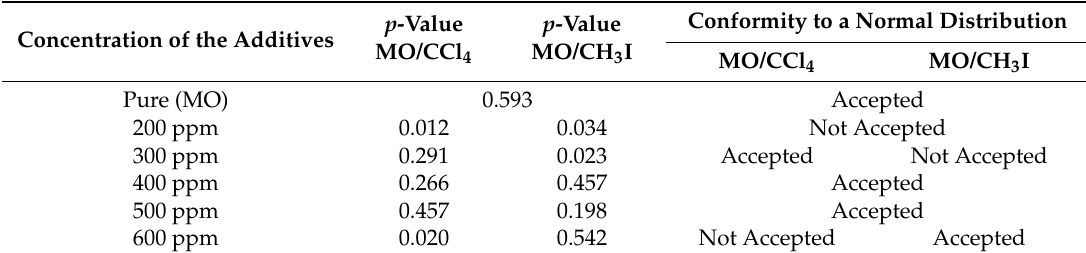
Table 3. The p -value of the mineral oil with various concentrations of the CCl 4 and CH 3 I electronic scavenger additives.